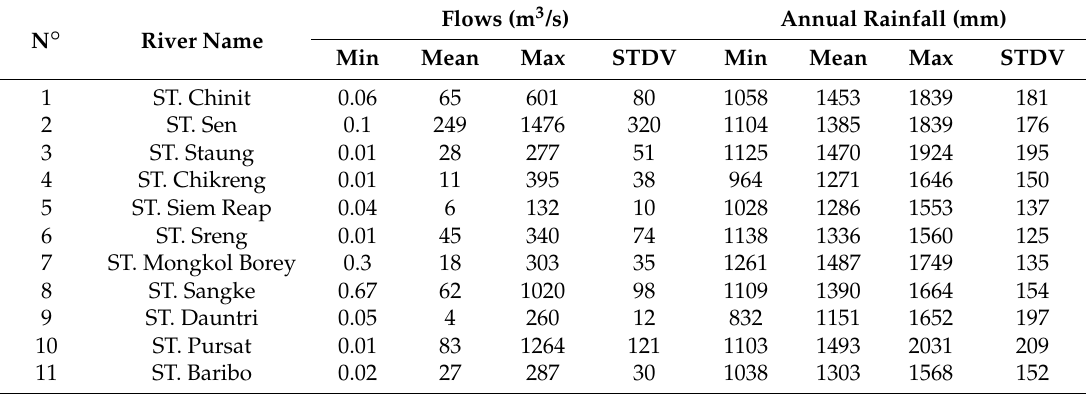
Table 2. Basic statistics of the river flow and annual rainfall of Tonle Sap River Basin. N ◦ River